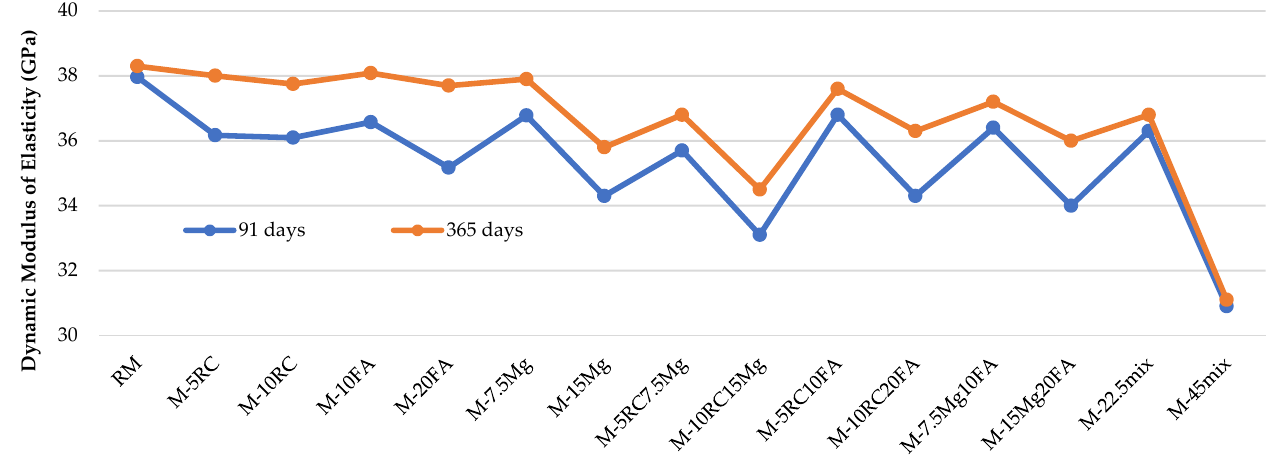
Figure 5. Dynamic modulus of elasticity at 91 and 365 days.